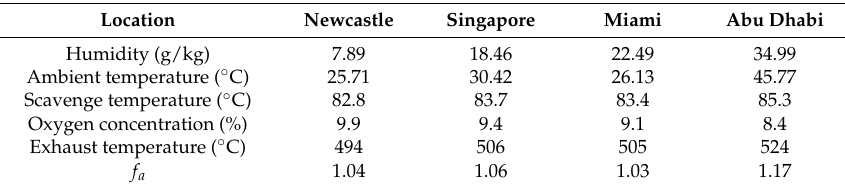
Table 2. Ambient test conditions.